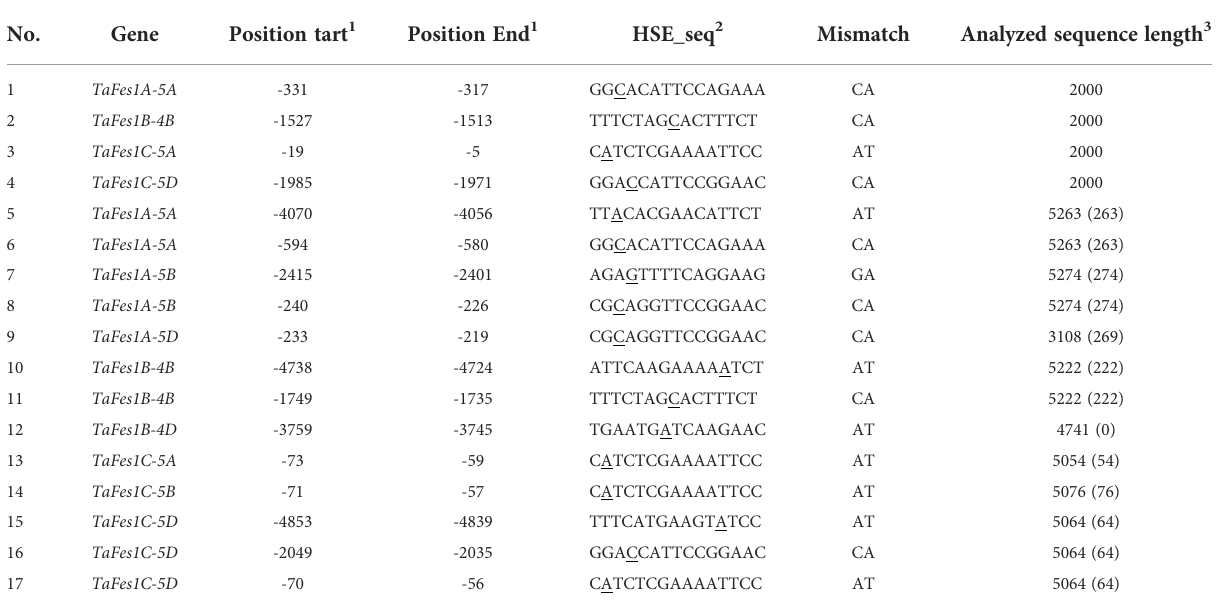
TABLE 3 HSEs in TaFes1s promoters.